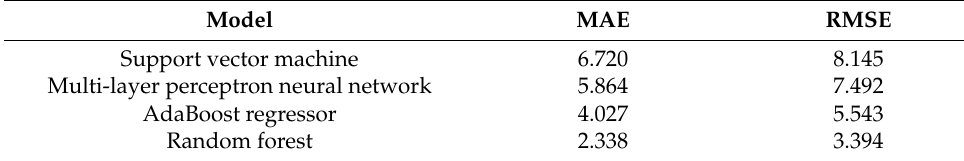
Table 2. Statistical checks of the ML methods used in the present